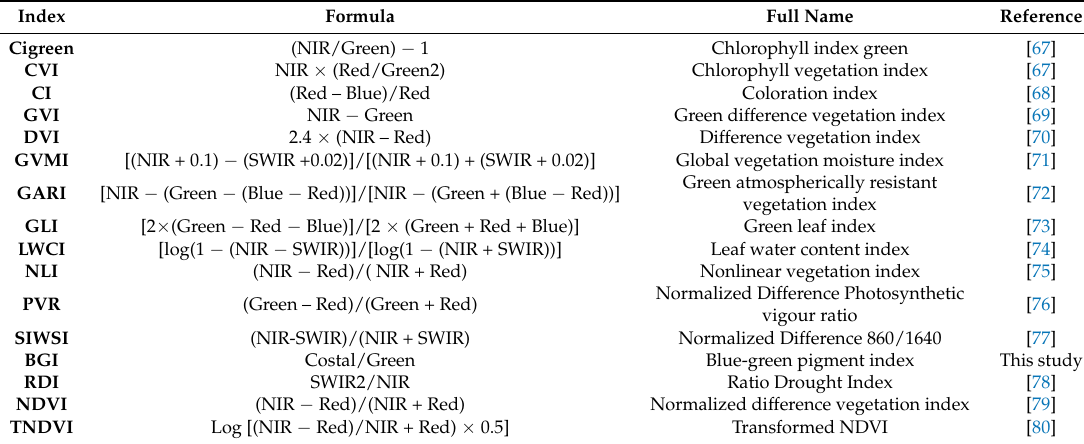
Table 2. List of spectral vegetation indices calculated from Landsat-8 optical